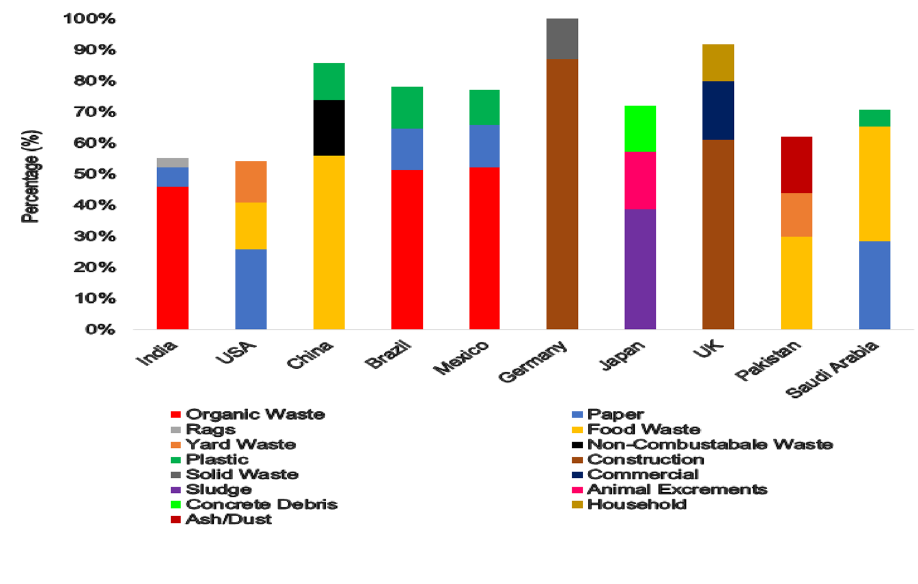
Fig. 7 Total MSW generated